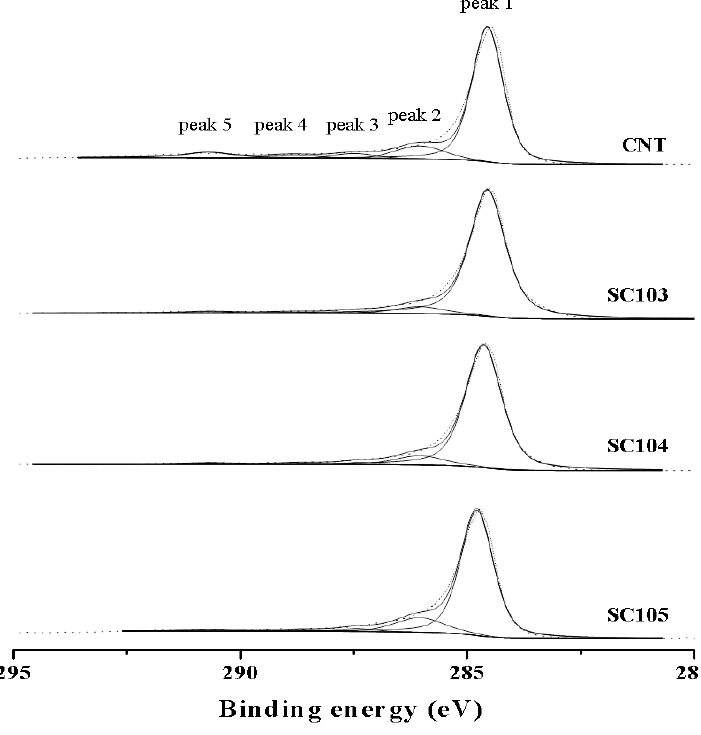
Figure 6. C-1s XPS profiles of CNT and SiO